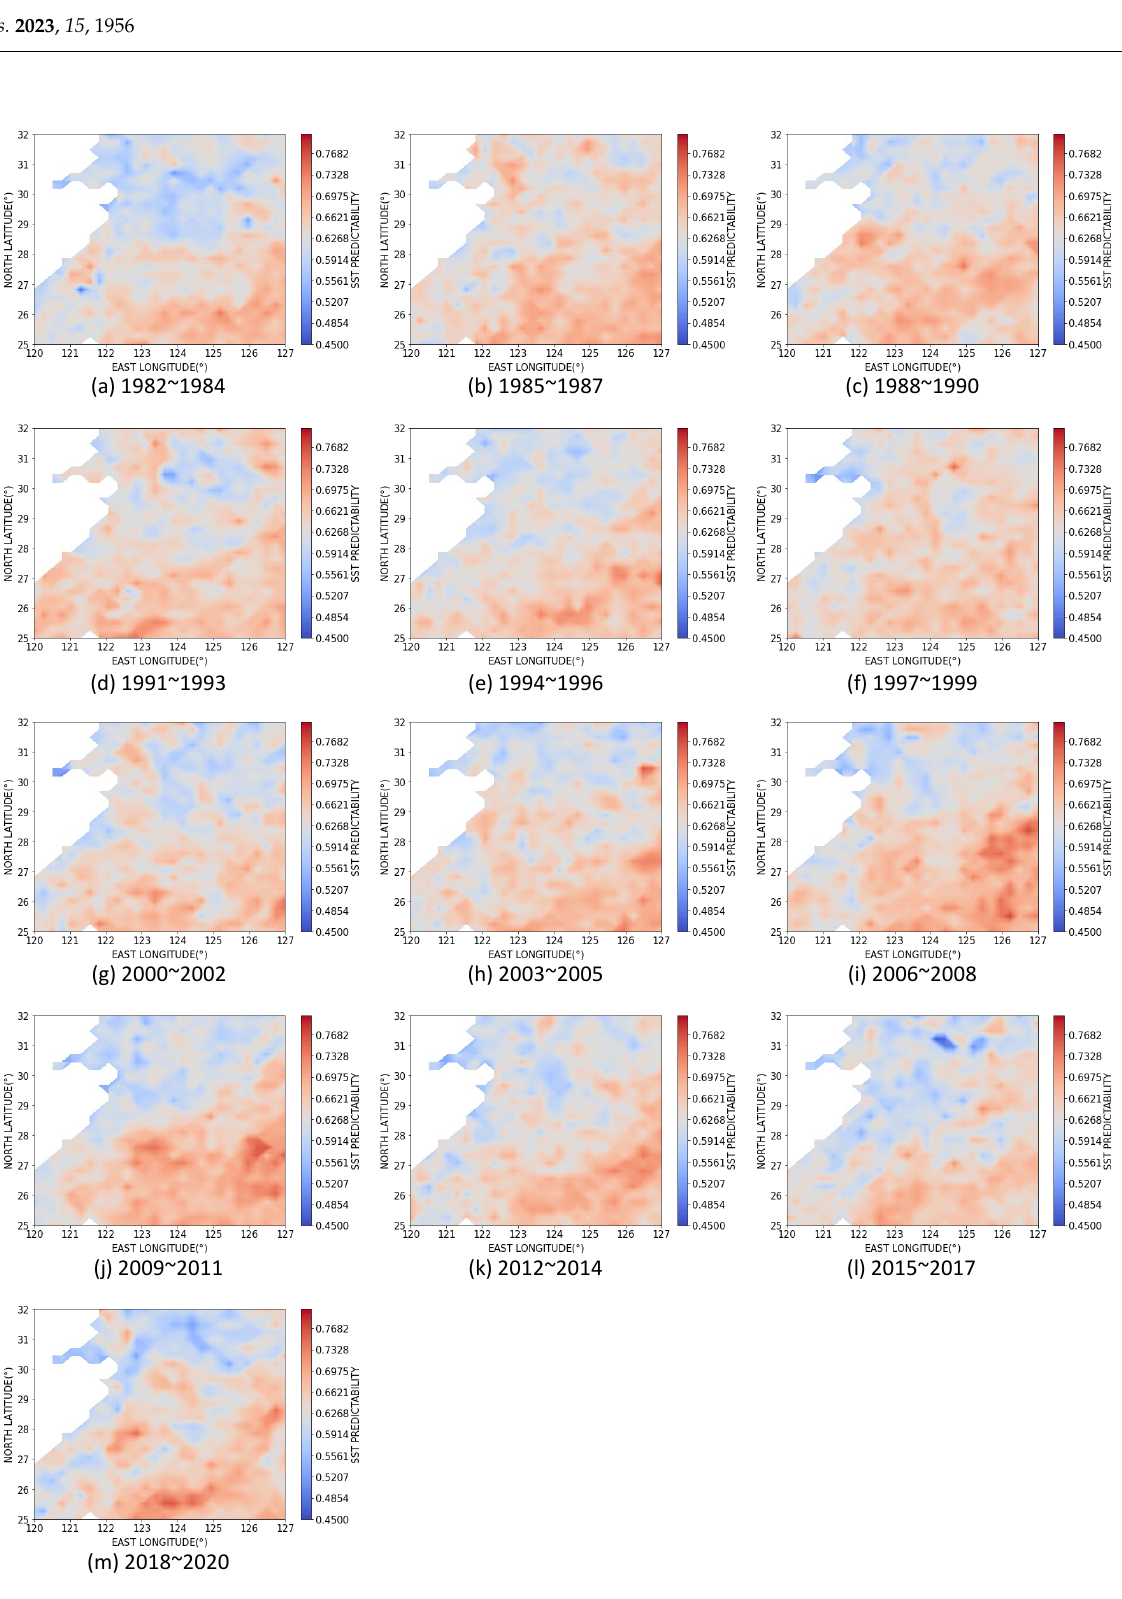
Figure 15. The predictability of SST in the East China Sea in 13 time periods from 1982 to